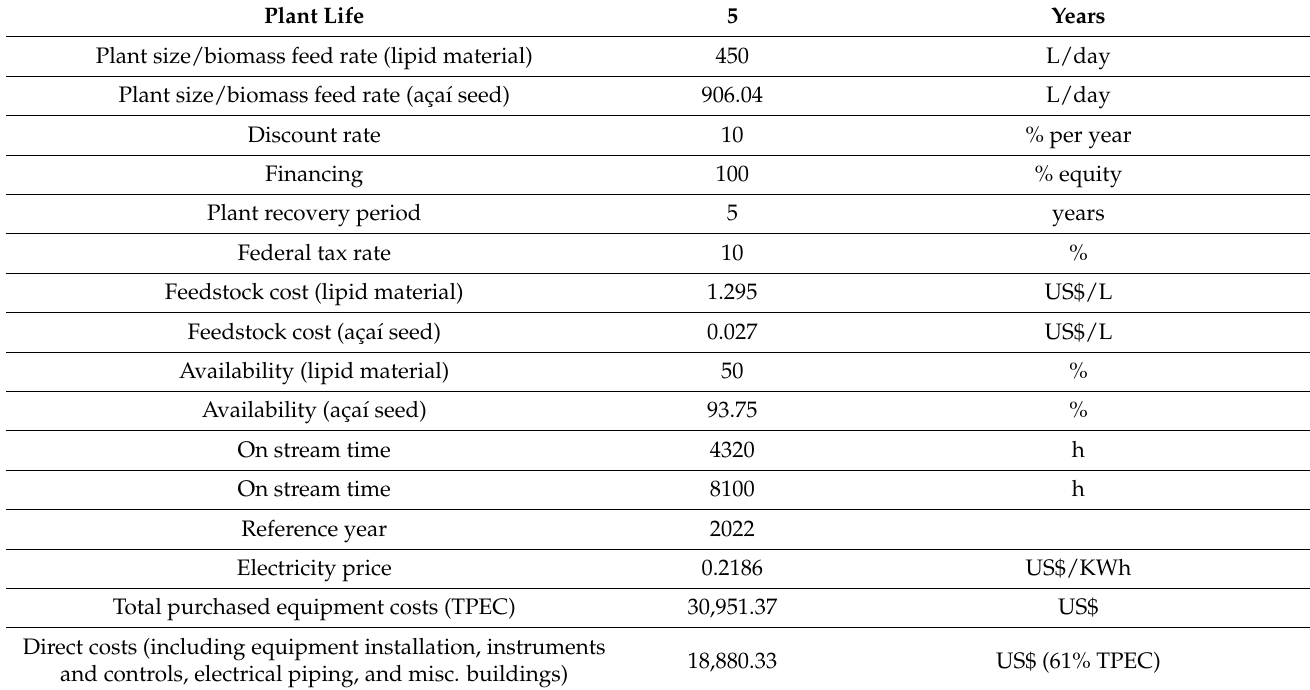
Table 2. Economic Parameters for Discounted Cash Flow